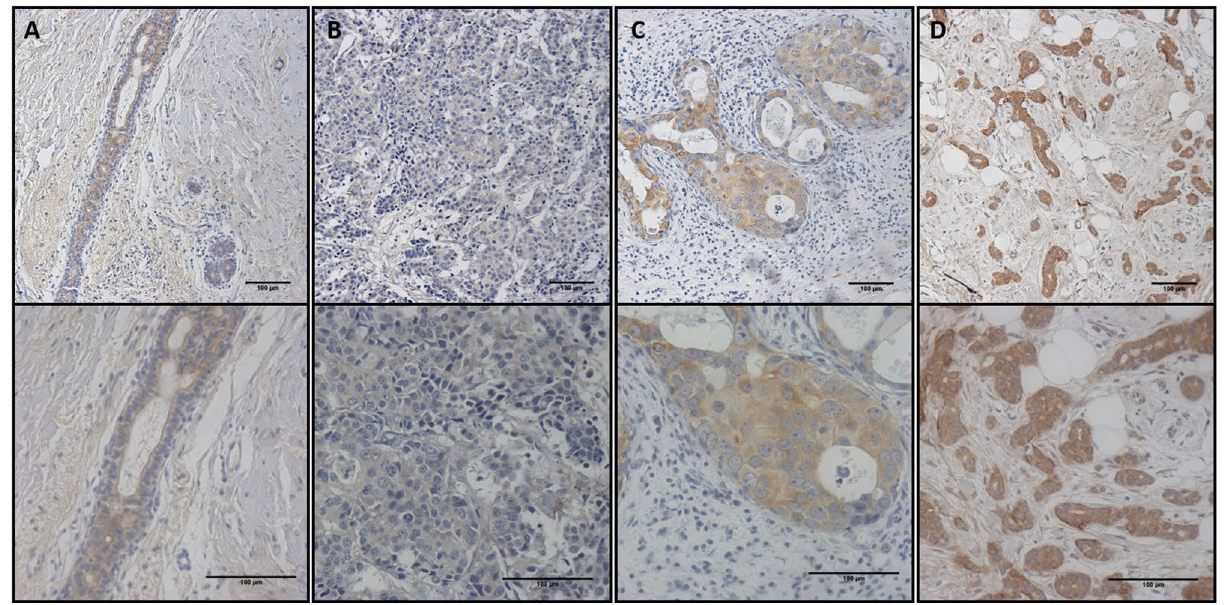
Figure 1. Patterns of expression of DIO3 in breast samples. Immunostaining was performed as described in Materials and Methods. From left to right: ( A ) normal glandular breast tissue, ( B ) breast carcinoma with low expression (overall intensity 1+), ( C ) breast carcinoma with moderate expression (overall intensity 2+) and ( D ) breast cancinoma with high expression (overall intensity 3+) of DIO3 protein evaluated